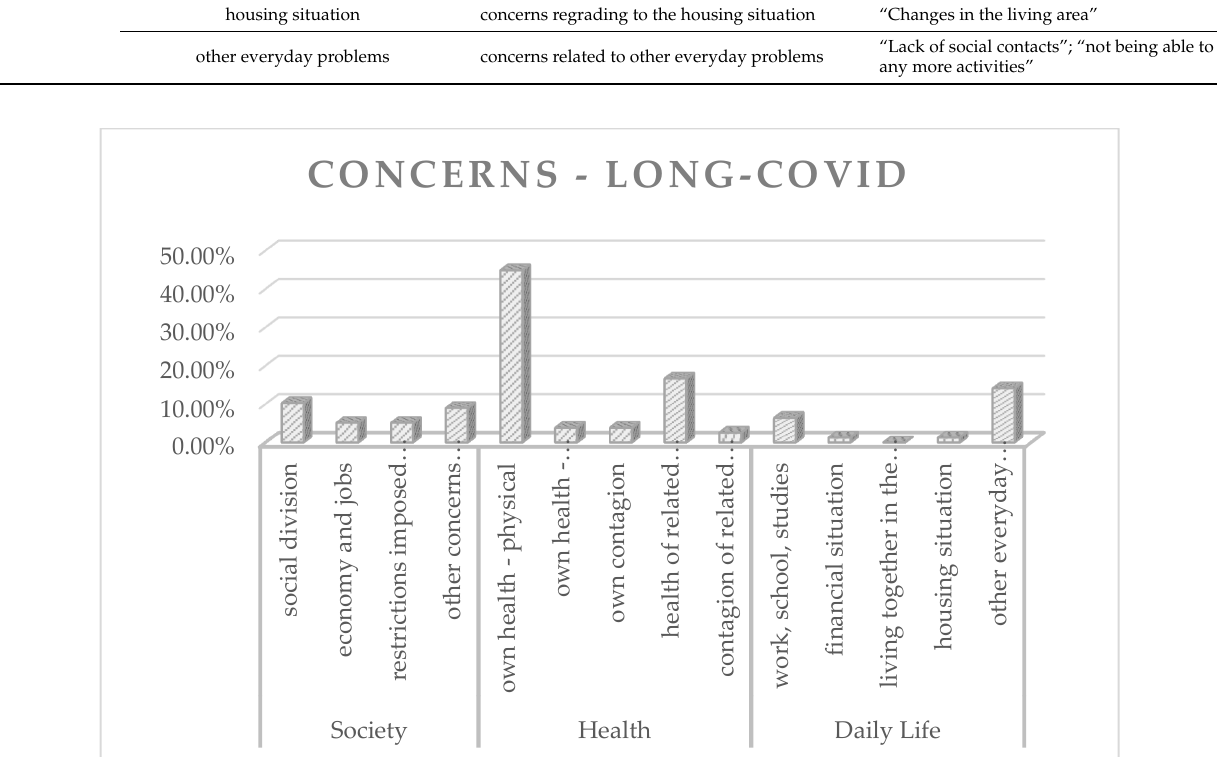
Figure 3. Percentages of pandemic-related concerns within the group “Long-Covid” .